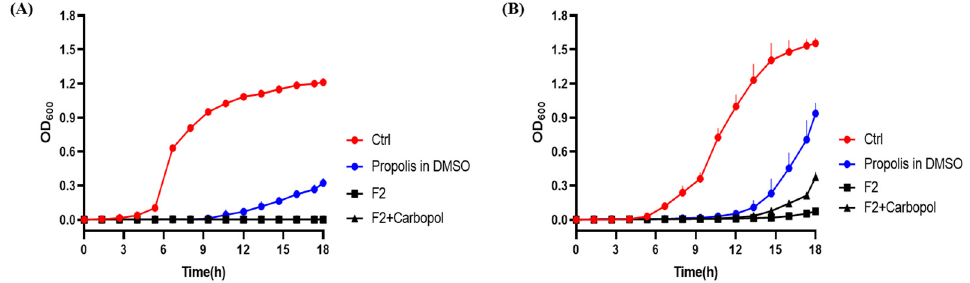
Figure 7. Time-kill kinetics of S. aureus ( A ) and C. albicans ( B ) incubated with F2 and F2 containing Carbopol. Data are presented as mean ± S.D. ( n = 3).